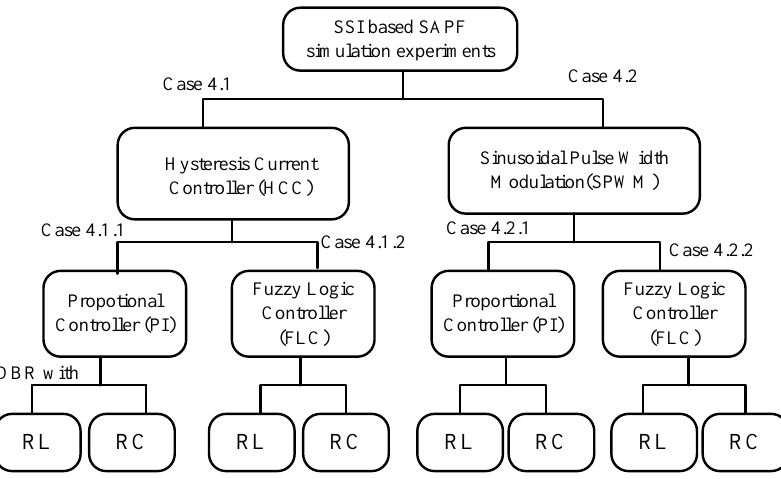
Figure 6. Simulation of experimental conditions employed in this